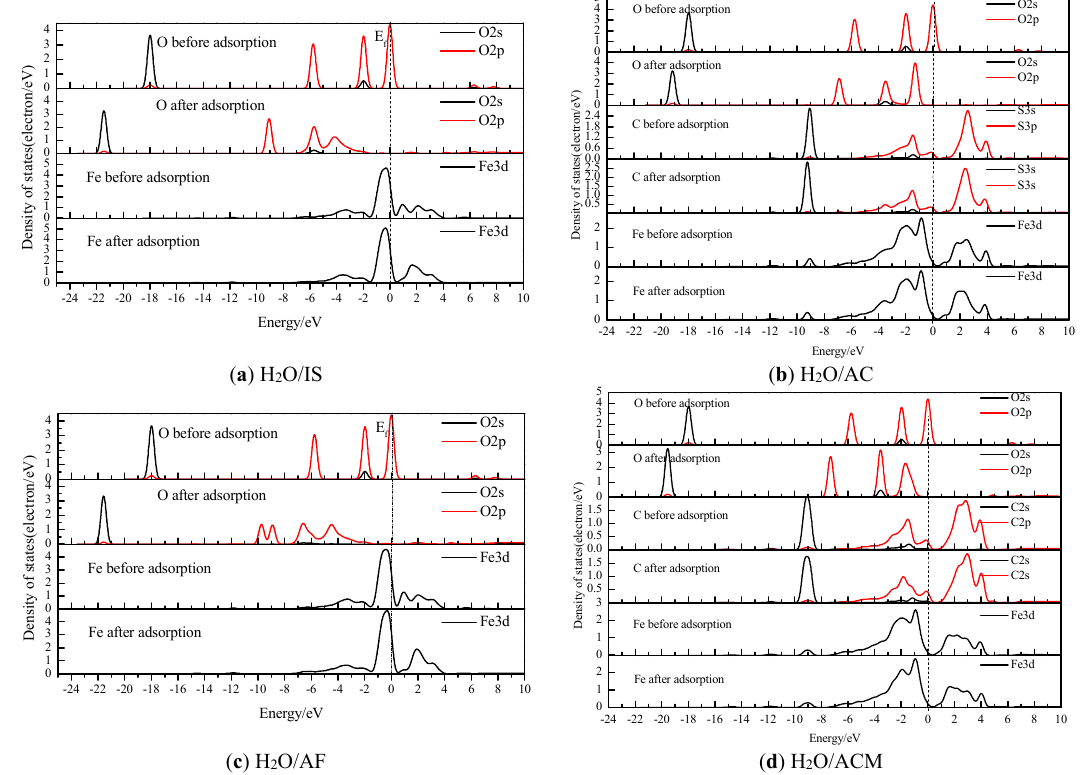
Figure 5. Density of states (DOS) of atoms before and after H 2 O adsorption on different pyrite surfaces.